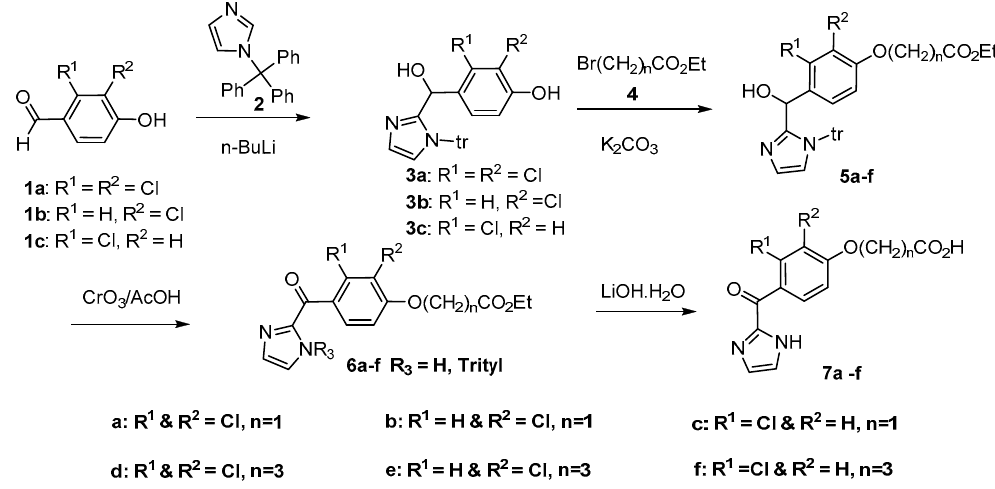
Scheme 1 . Synthesis of {[2,3-Di/mono substituted-4-(1 H -imidazol-2yl)carbonyl]-phenoxy}acetic/butyric acids .